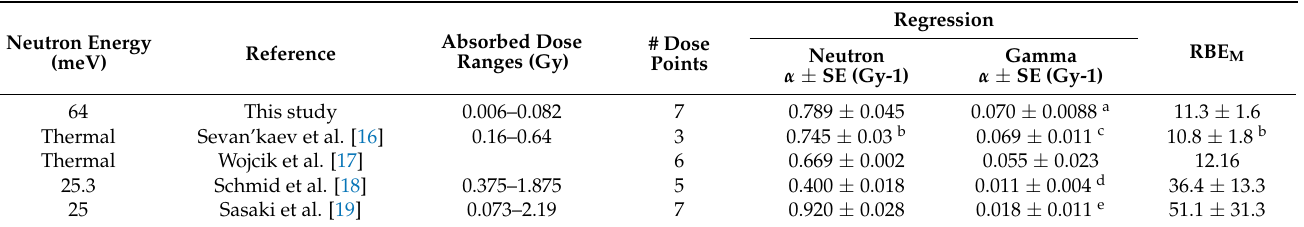
Table 1. Comparison of DCA RBE M and linear regression ( α coefficient) values in human peripheral blood lymphocytes following thermal neutron